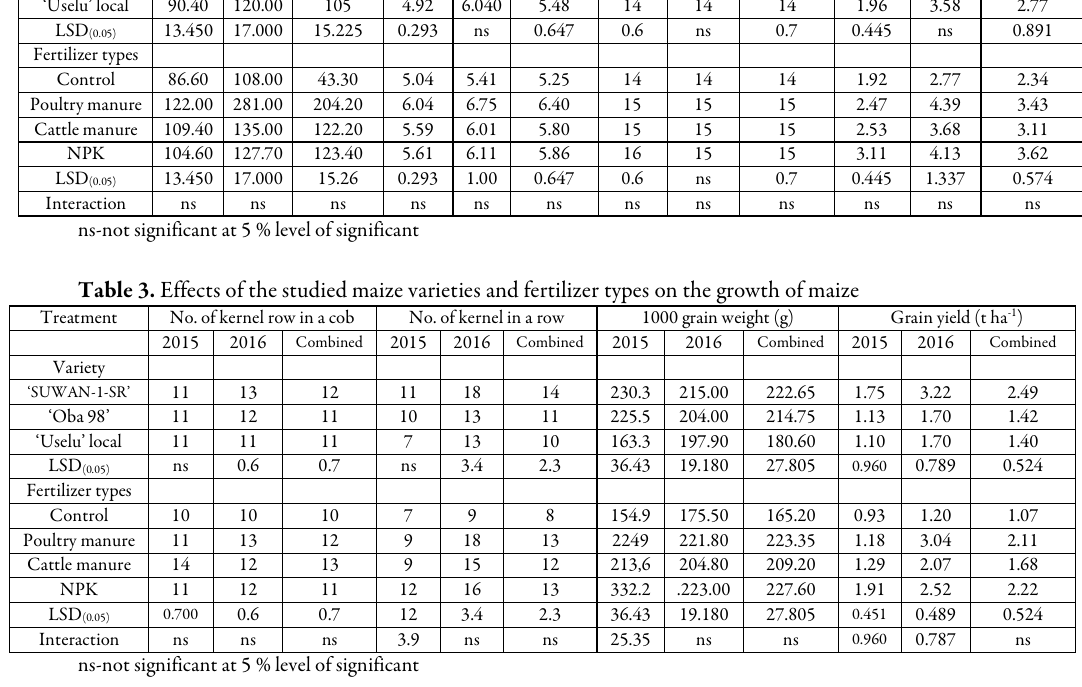
Table 2. Effects of the studied maize varieties and fertilizer types on the growth of maize Treatment Plant height (cm) Stem girth (cm) ‘SUWAN-1-SR’ 113.80 218.00